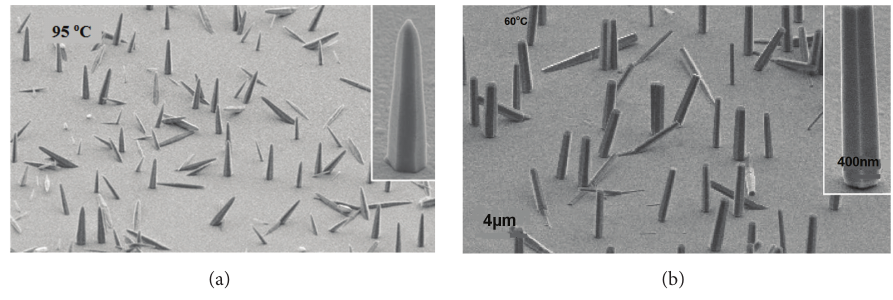
Figure 4: ZnO nanorods grown at different temperatures